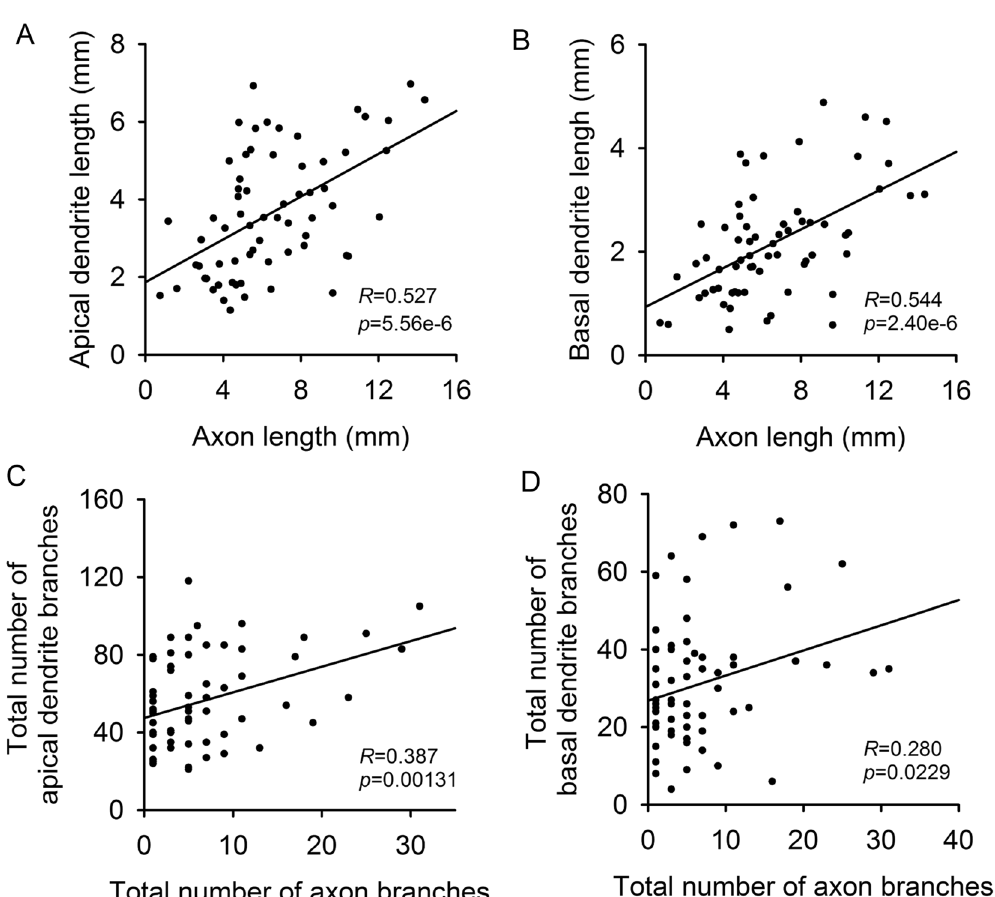
Figure 6. Linear correlations of the axonal and dendritic complexity parameters of L5 type I neurons, where R represents the Pearson correlation coefficient and p represents the p - value